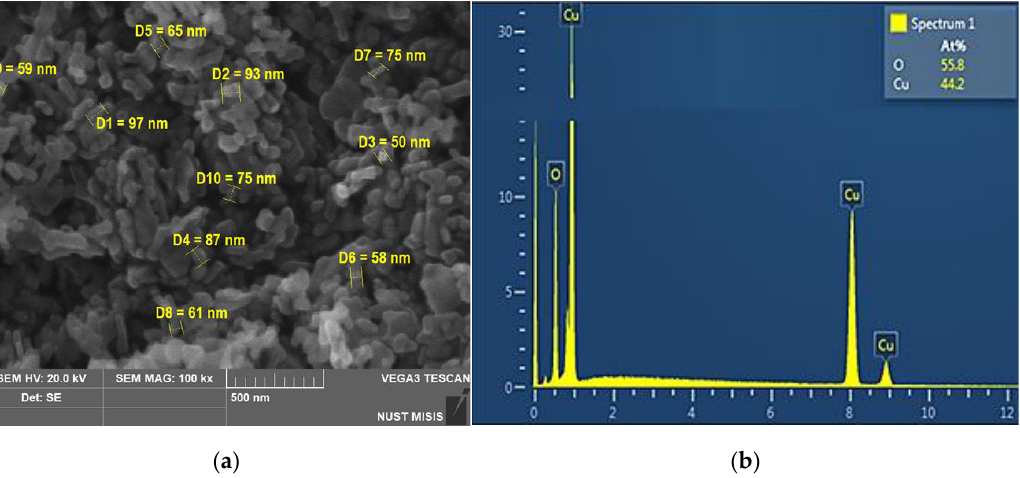
Figure 1. Electron microscopic examination of CuO NPs powder: ( a ) SEM image indicates that the studied material consists of nanoparticles; ( b ) EDX analysis confirms that the chemical composition of nanoparticles includes copper and oxygen.